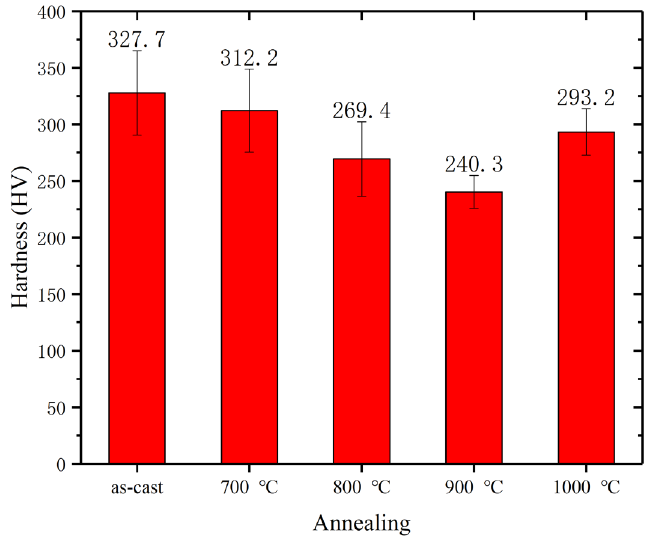
Figure 5. Microhardness of (FeNi)67Cr15Mn10Al5Ti3 HEA at different annealing